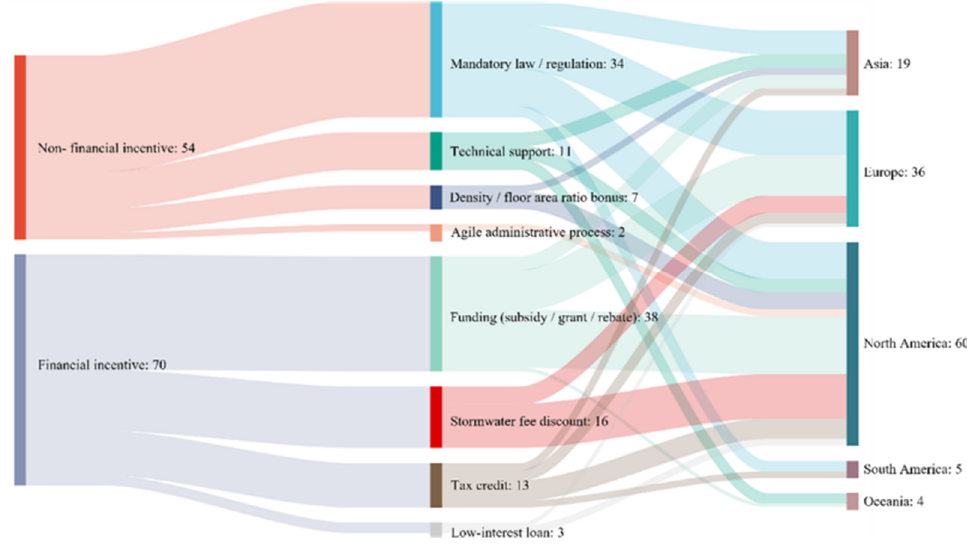
Figure 7. Number of incentives for different types of green roofs.